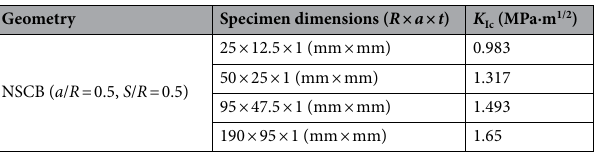
Table 3. The test data of fracture toughness of rock specimens with NSCB configuration in different sizes from Ayatollahi et al. 38 .